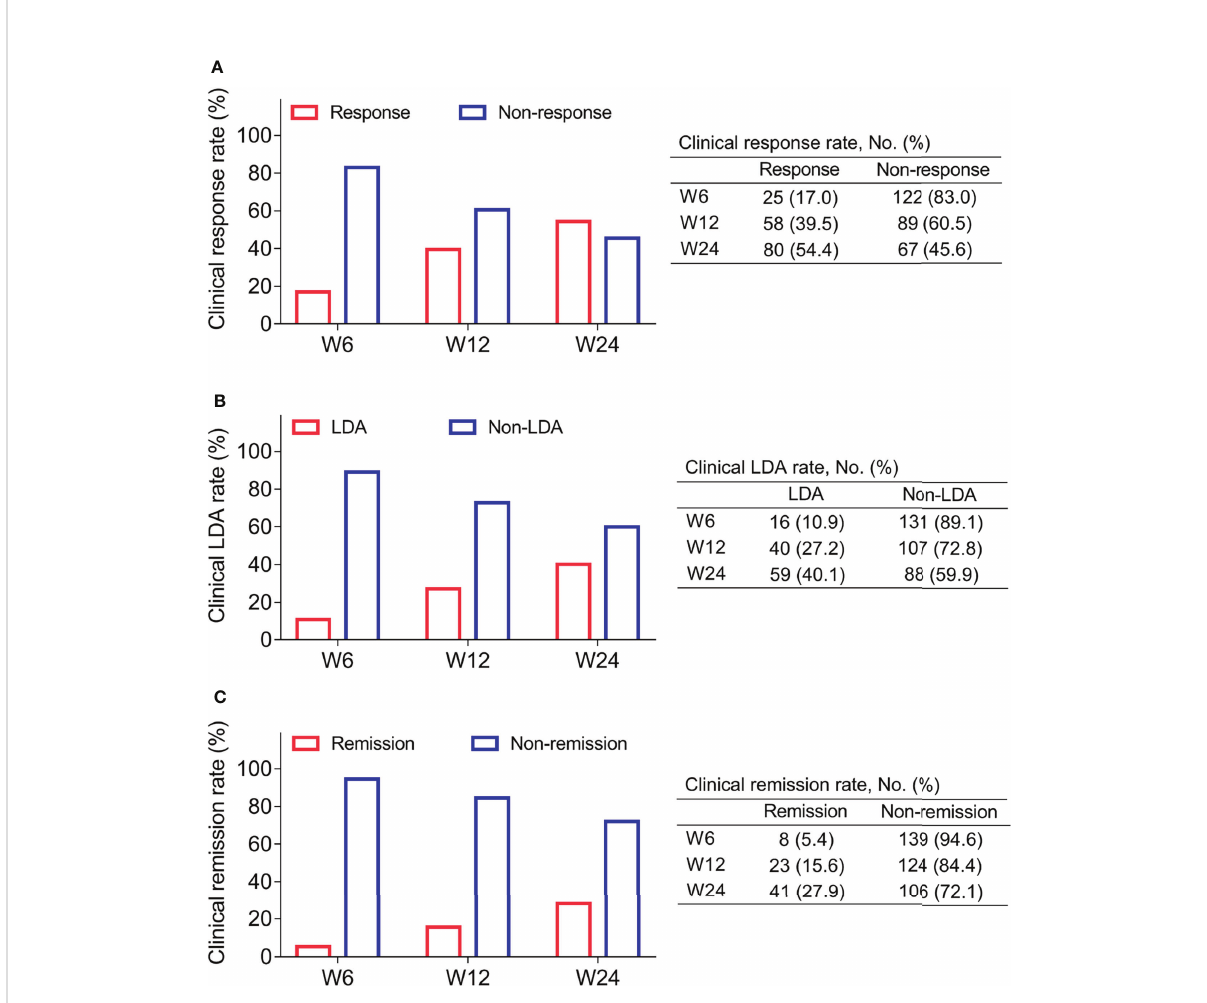
FIGURE 3 Treatment outcome. Clinical response rate (A) , clinical LDA rate (B) , and clinical remission rate (C) at W6, W12, and 24 in RA